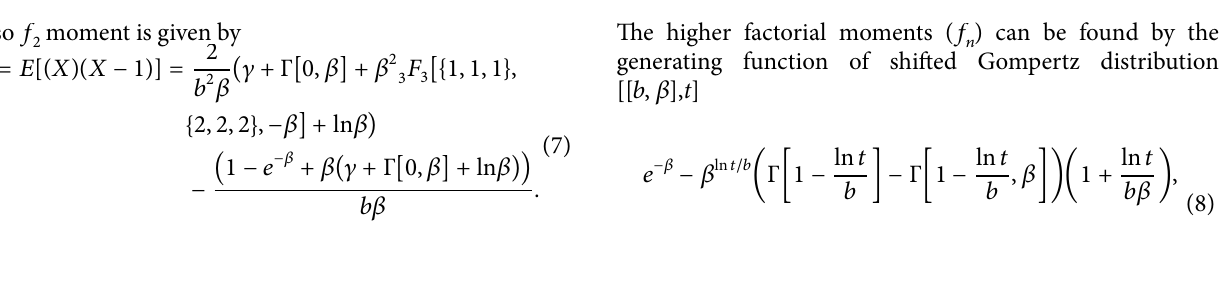
Figure 2: Charged multiplicity distributions from L3 experiment. Solid lines represent the shifted Gompertz distribution and the modified shifted Gompertz